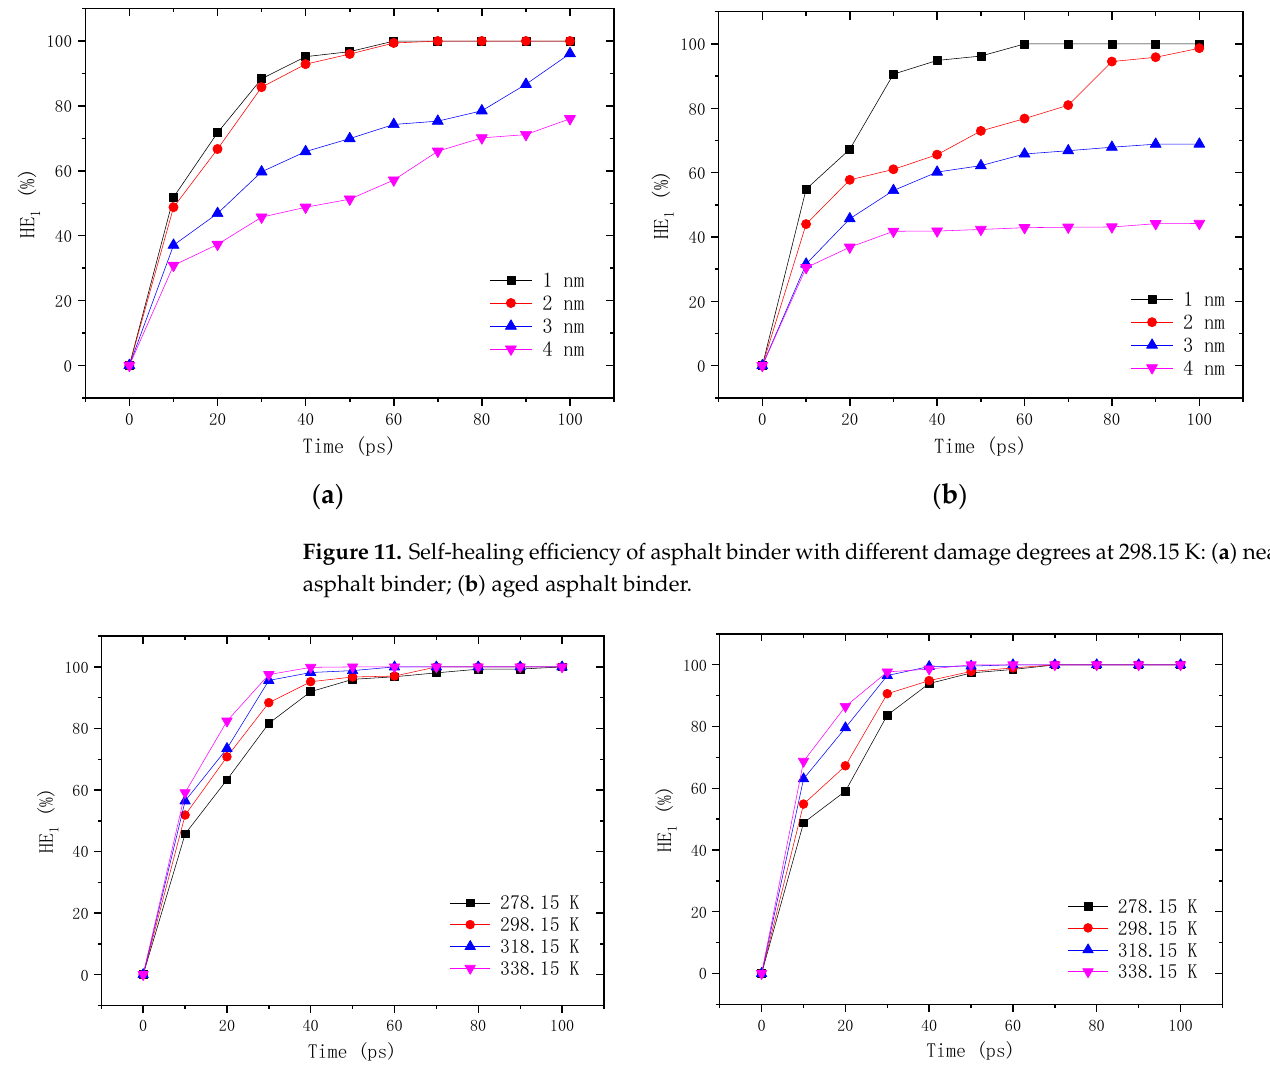
` ( a ) ( b ) Figure 13. MSD-time curve of self-healing model of asphalt binder with 1 nm crack at the intrinsic healing stage: ( a ) neat asphalt binder; ( b ) aged asphalt binder.